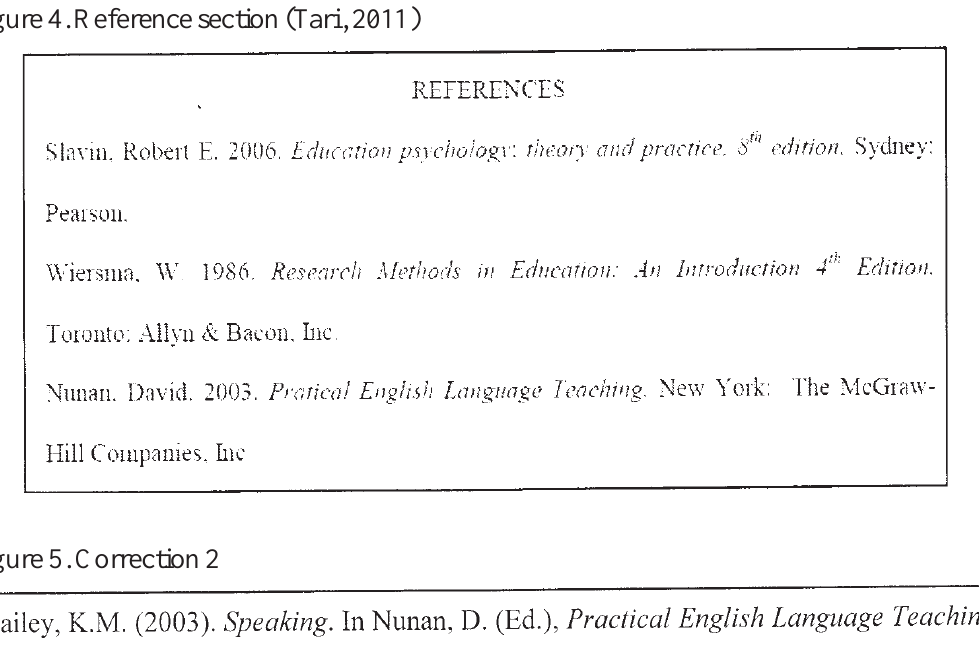
Figure 5. Correction